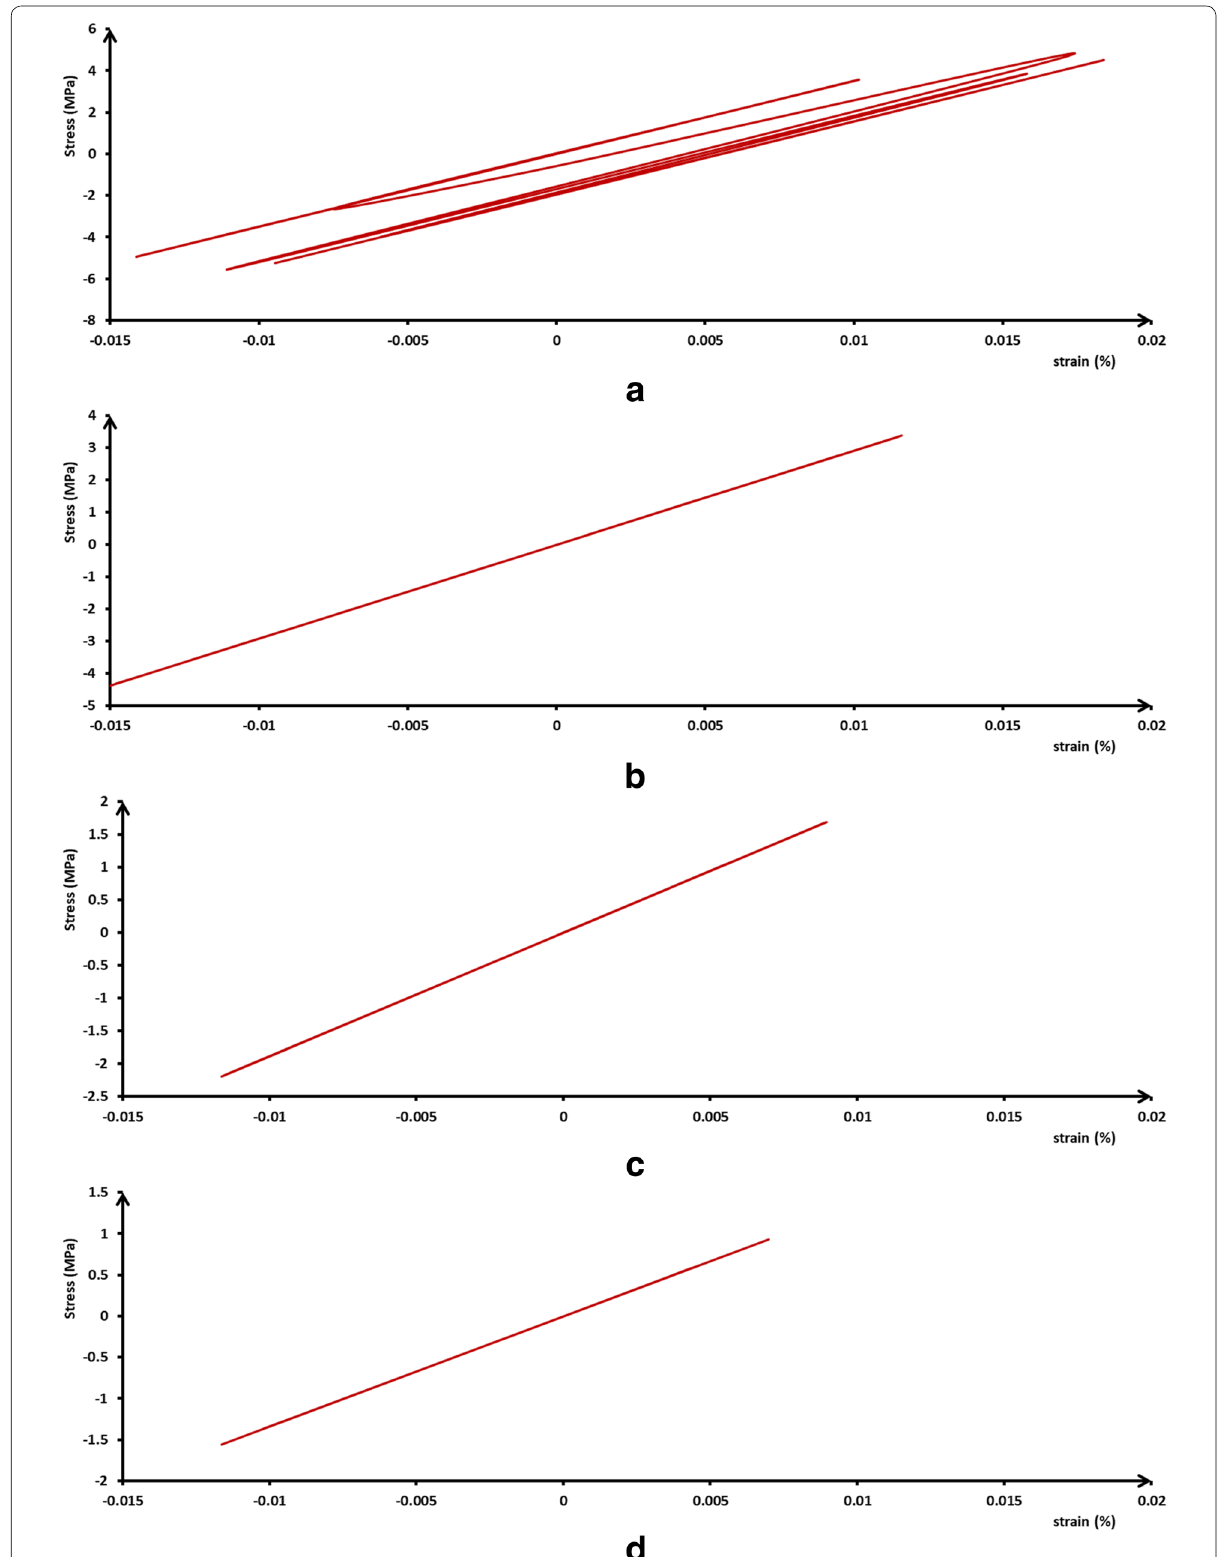
Fig. 18 The variation of strain with stresses at ground floor level of the column: ( a ) M0 ( b ) M10 ( c ) M15 ( d )